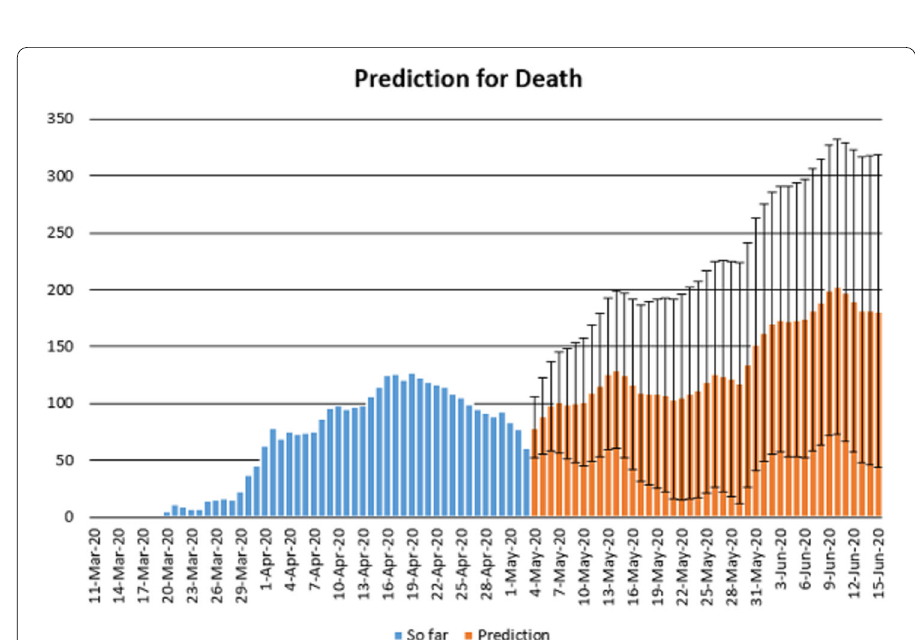
Figure 19 Prediction of daily number of recovered in Turkey using forecast sheet with reliability level of 97%